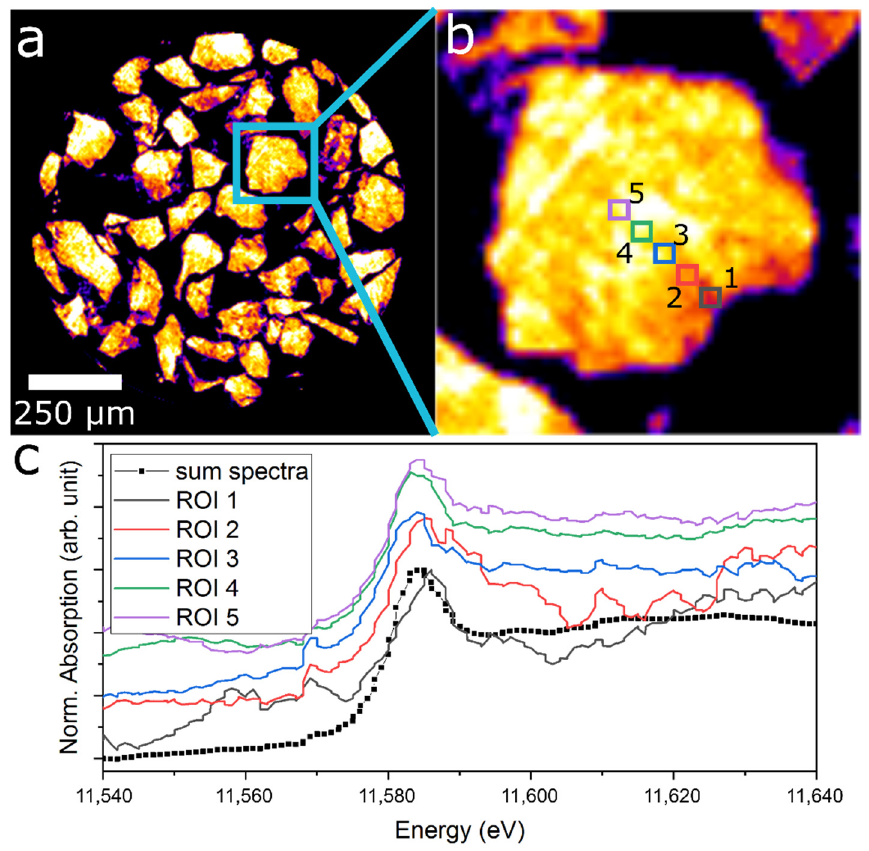
Figure 7. Overview of the sample measured at 553 K; ( a ) reconstructed slice with the capillary masked out and color-coding depicting the absorption intensity at 11,585 eV; ( b ) extracted single particle of the same slice with marked regions of interest; ( c ) XANES spectra extracted from each region of interest, compared with the sum spectra of the whole slice.